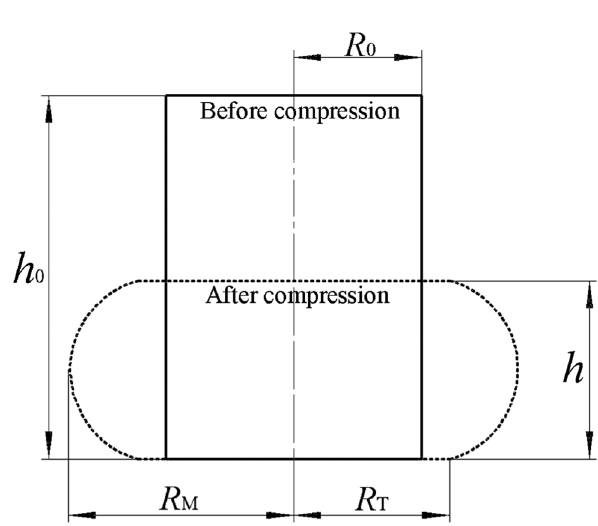
Figure 1: A simple representation of the solid compression